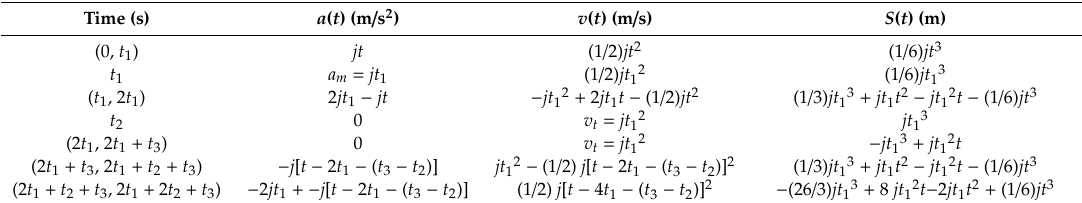
Table 1. Expressions of acceleration, velocity and displacement for each stage in the S-shaped velocity curve.